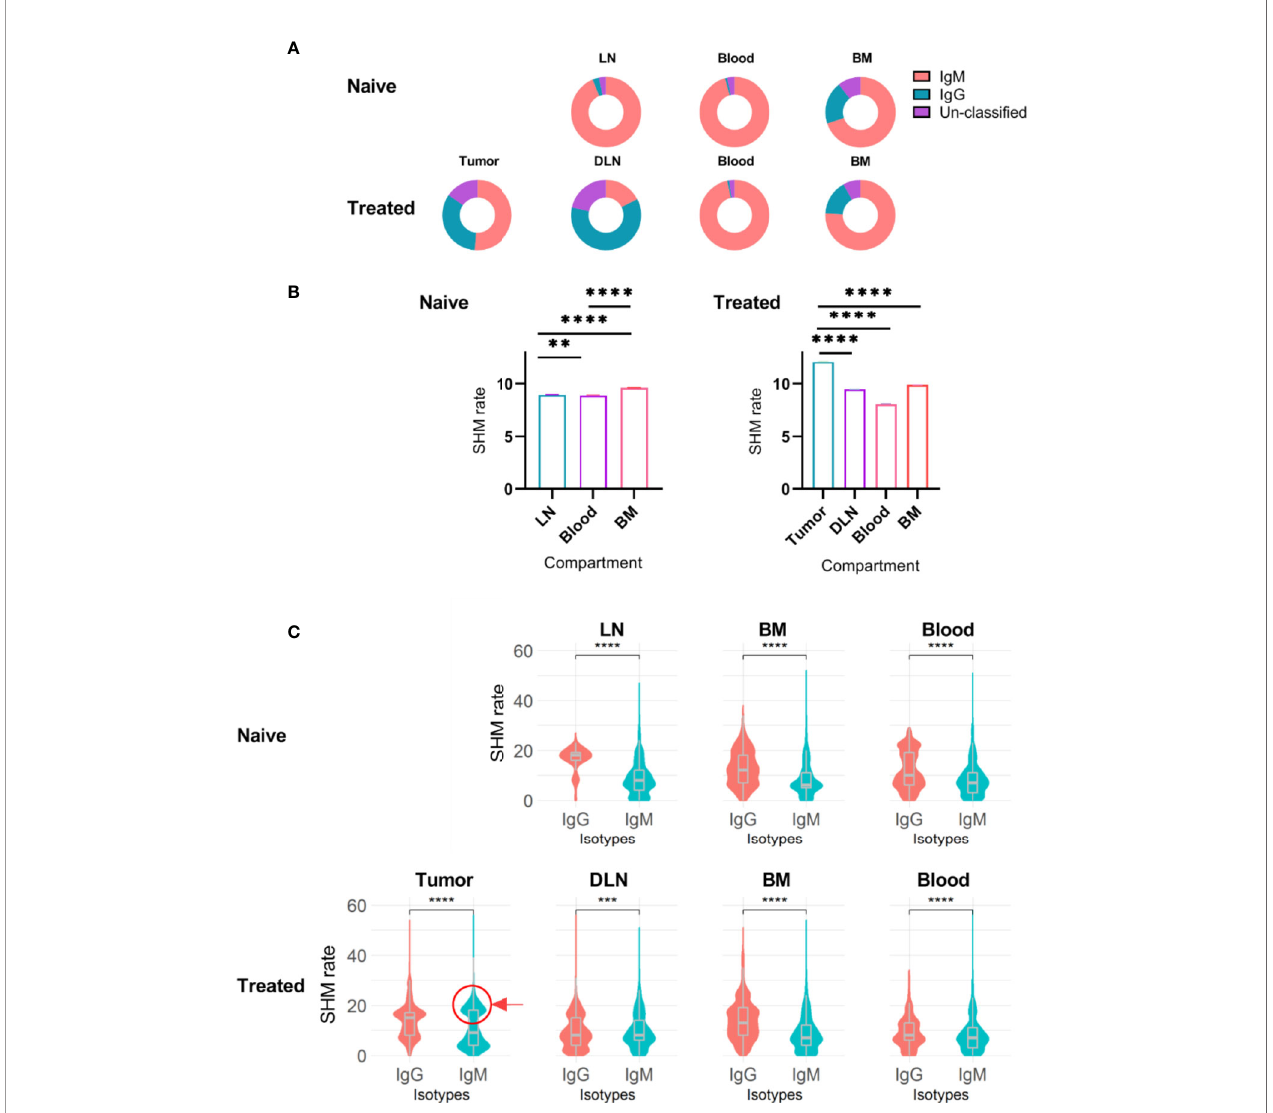
FIGURE 4 | Isotype distribution and SHM rate in B cells isolated from different tissues. (A) Doughnut chart for the distribution of immunoglobulin isotypes encoded by B cells isolated from different tissues in treated and untreated mice. (B) Bar plots of SHM rate identi fi ed in the V H regions of B cells isolated from each tissue. Error bars represent the standard error of the mean (SEM). (C) Violin charts showing the distributions of the SHM rate within each immunoglobulin isotype across tissues. The violin curves show the density of values; median, lower and upper quartile values are indicated. The red circle and arrow highlight the IgM + B cell population that exhibits high SHM rates. Statistical signi fi cance for (B, C) was evaluated with the nonparametric, unpaired Mann-Whitney t-test (two-sided; ****p ≤ 0.0001, ***p ≤ 0.001, **p ≤ 0.01). Naïve - naïve mice, Treated - tumor-bearing